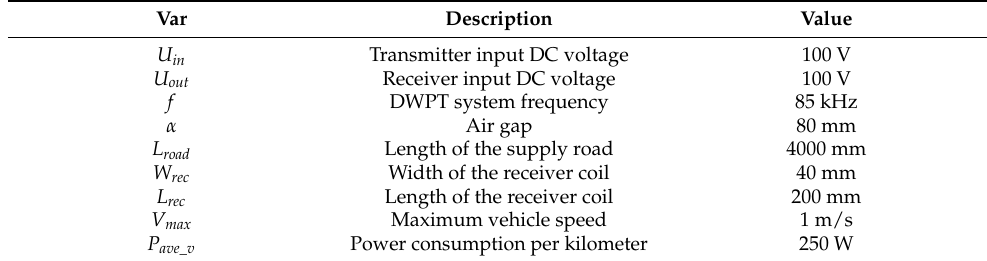
Figure 6. Multi-objective optimization process of DWPT systems. Table 1. System specifications and constructive limitations.